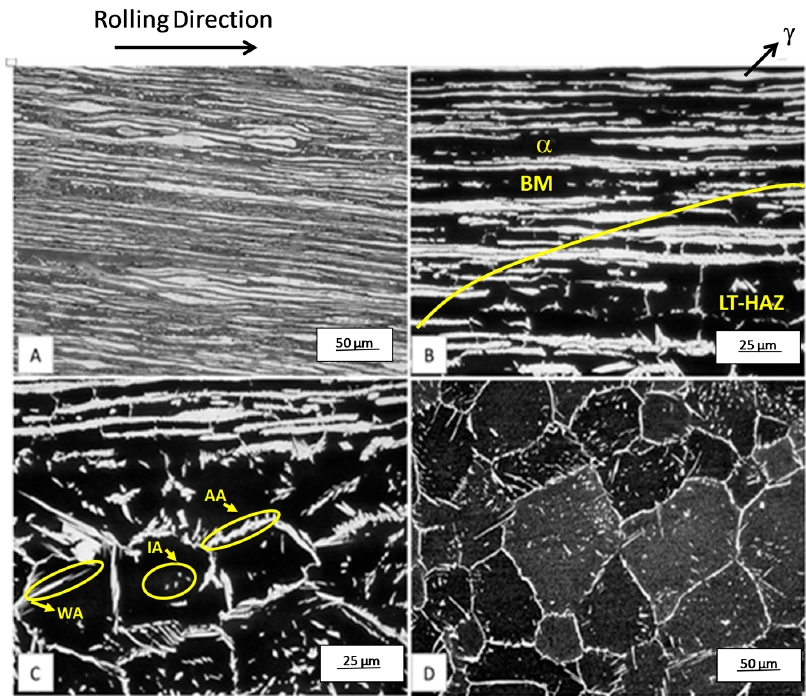
Figure 2. SAF 2205—Low heat input: ( A ) base metal (BM); ( B ) BM/low temperature heat affected zone (LT-HAZ); ( C ) high temperature heat affected zone (HT-HAZ); ( D ) weld metal (WM); Beraha Etching. Where: α (ferrite—dark/dark brown), γ (austenite—light brown), WA—Widmanstätten Austenite, IA—Intragranular Austenite, AA—Allotriomorphic Austenite.